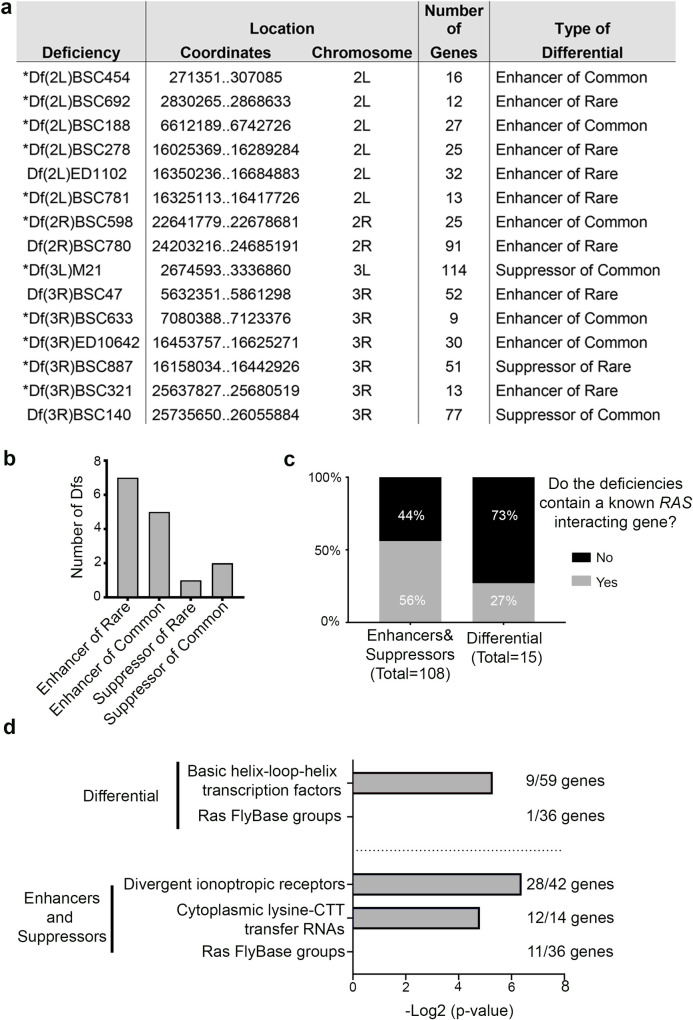
Characterization of differential modifiers.(a) Characterization of the differential Ras modifiers identified. Asterisks = those Dfs for which no known Ras modifier has been reported (see Methods). (b) Pie chart showing the number of differential modifiers with the indicated phenotypes. (c) Graph of the percent (and number) of Dfs that do or do not contain known Ras interacting genes. (d) Enriched FlyBase gene groups contained in differential versus enhancer and suppressor deficiencies. The x-axis indicates the Log2 of the adjusted P value.